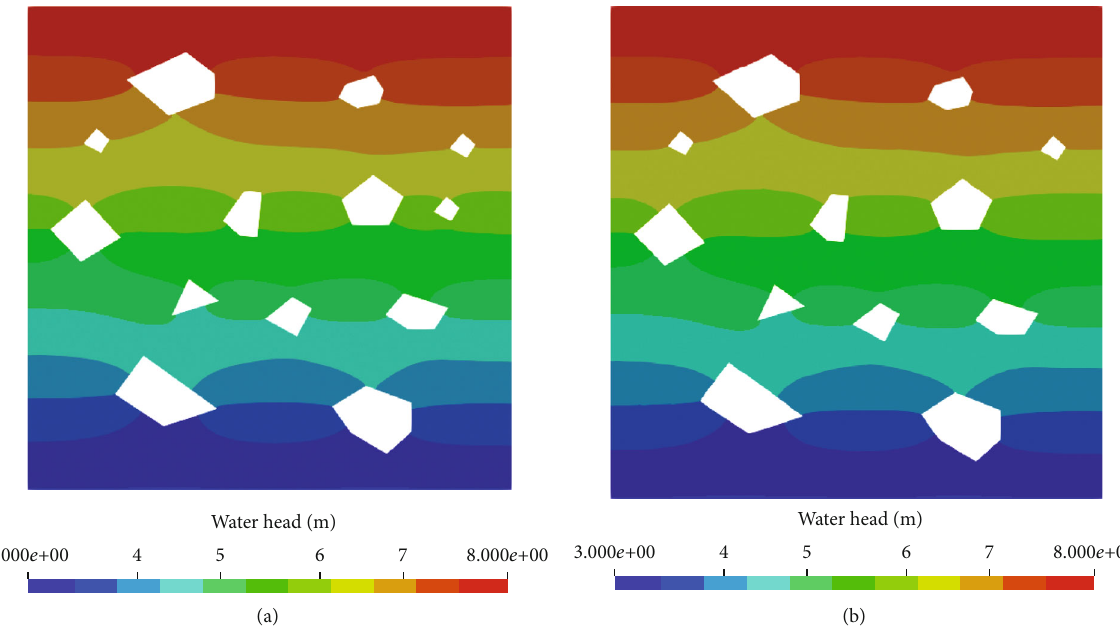
Figure 9: Water head distribution: (a) Abaqus CPE4P; (b) PSBFEM quadtree